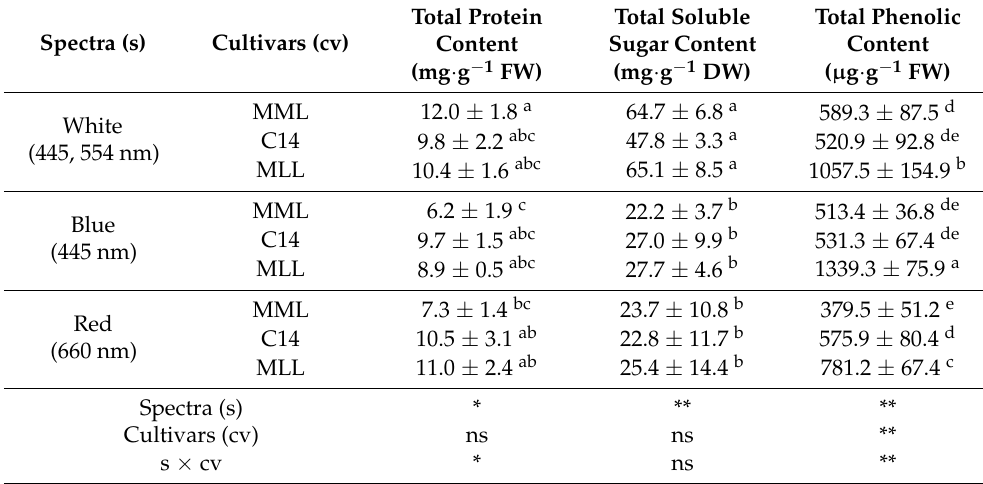
Table 3. Total contents of protein, soluble sugars, and phenolic compounds detected in leaves of mulberry plants that were exposed to different light spectra of white (445, 554 nm), blue (445 nm), or red (660 nm) for 7